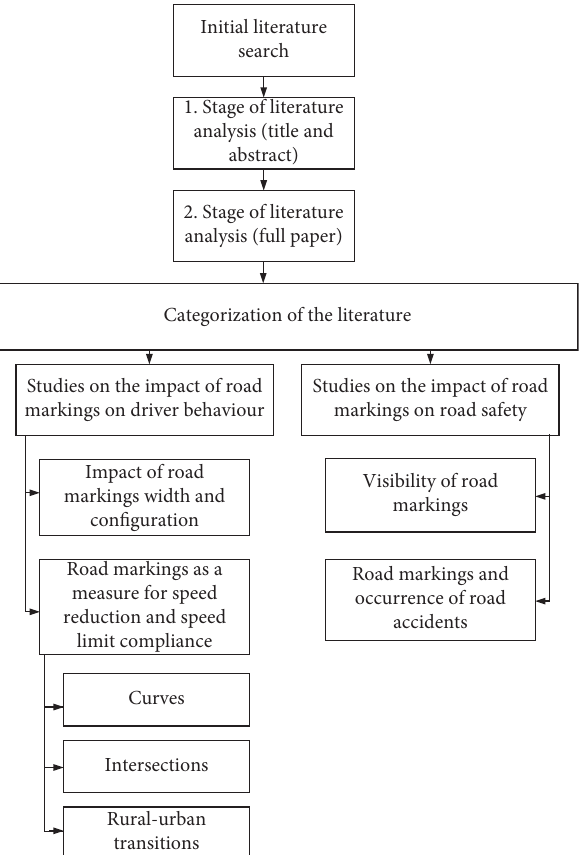
Figure 1: Literature selection process and